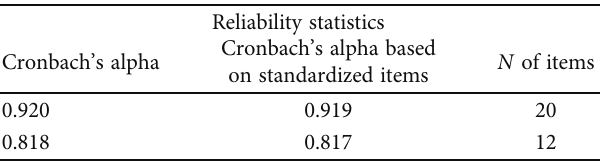
Figure 1: Depicts the sampling procedure of North Wollo zone correctional institutions, Northeastern Ethiopia. Table 1: Reliability test on SRQ-20(0.92) and Oslo-social support scale